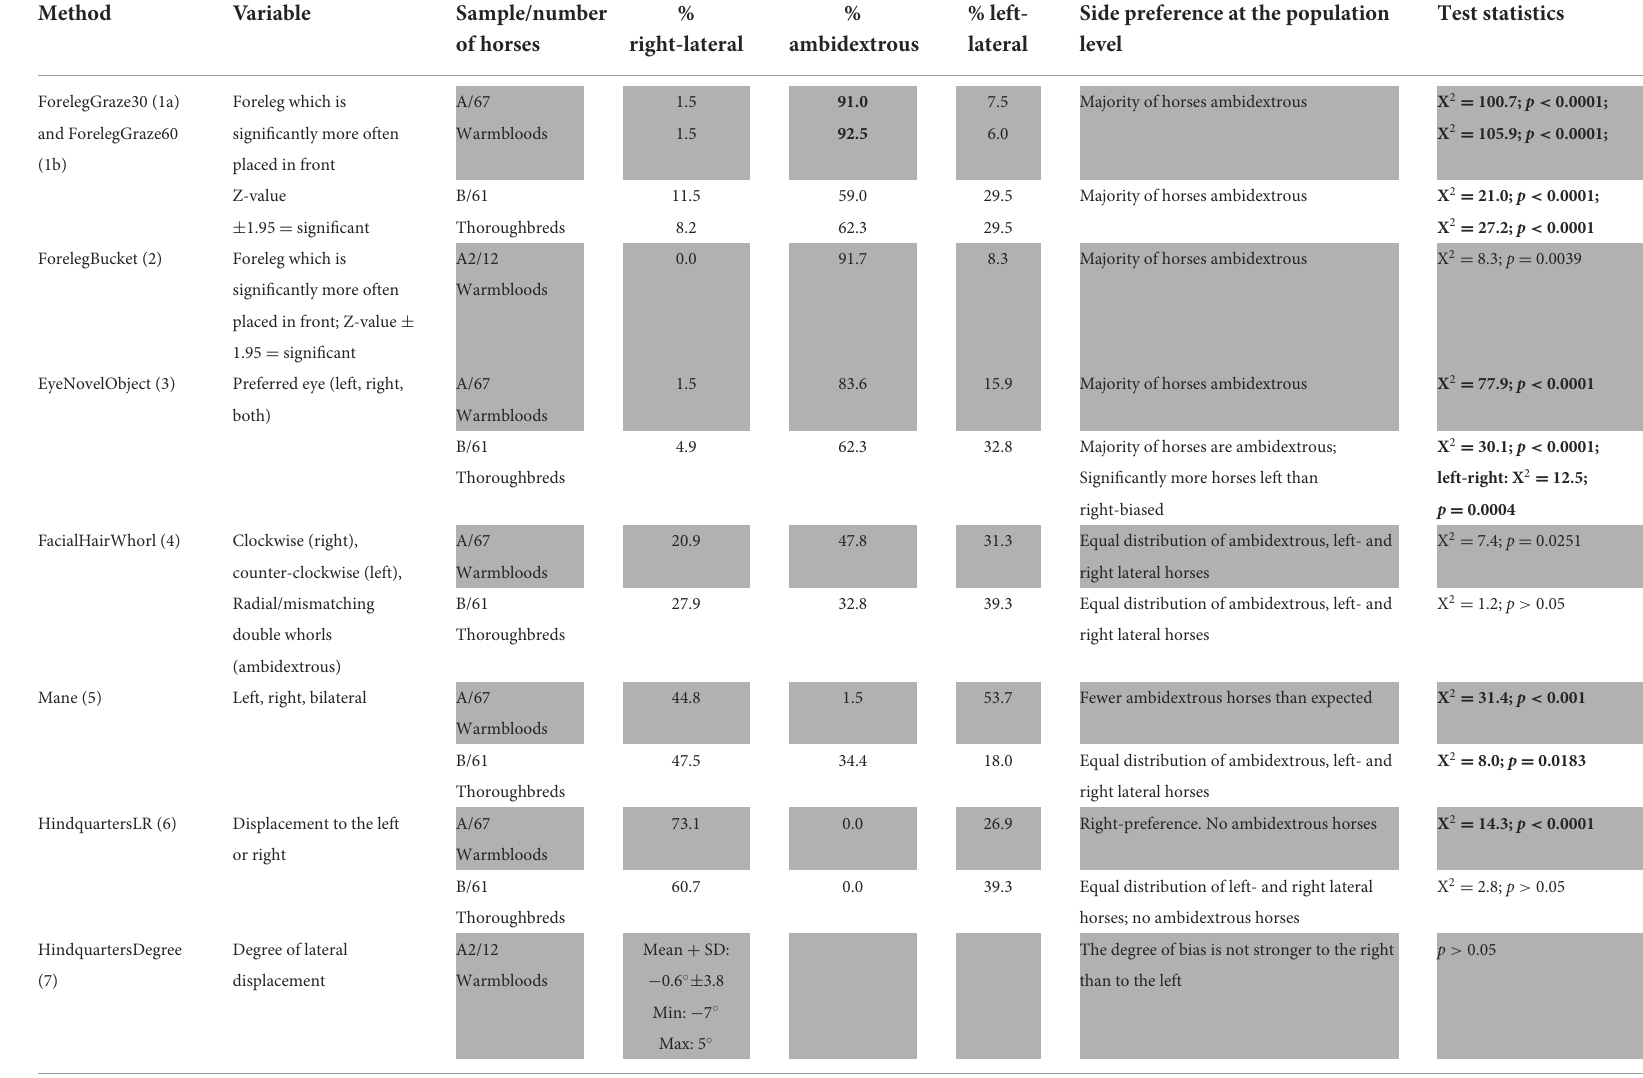
TABLE 1 Overview of the applied laterality test methods and proportions of respective laterality in the different sample populations.